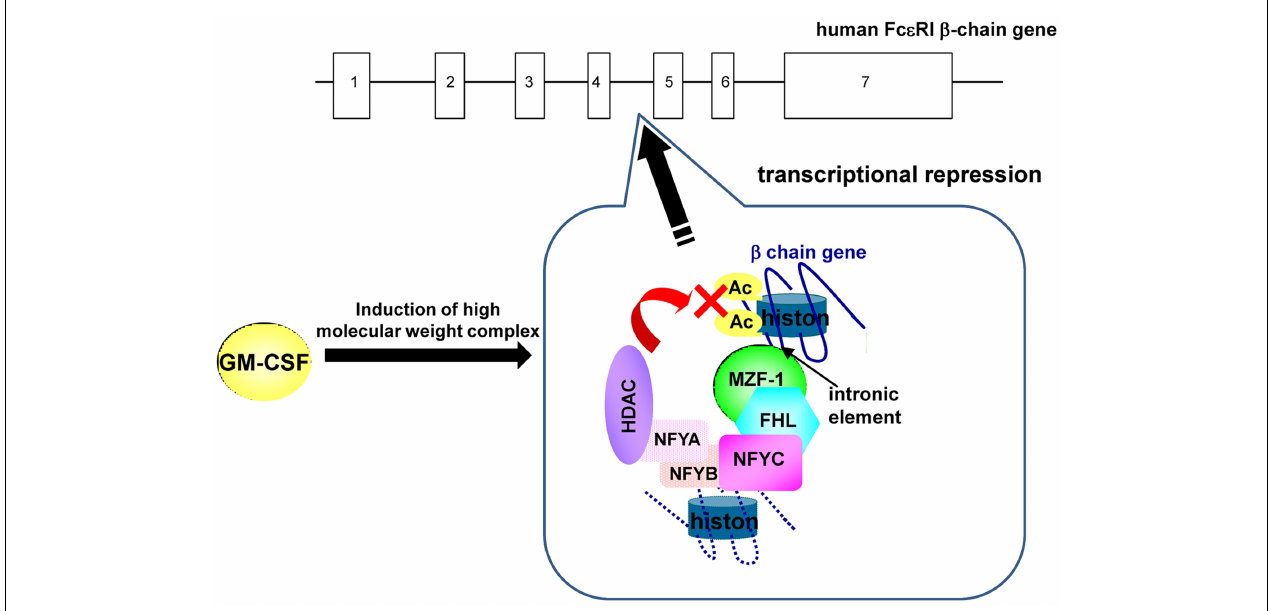
FIGURE 2 | GM-CSF-induced repression of Fc ε RI β gene expression in human mast cells. HDACs, which were recruited to the human Fc ε RI β gene through the element in the fourth intron by MZF-1/FHL3/NFY, repressed Fc ε RI β transcription through the deacetylation of histones in the presence of GM-CSF.